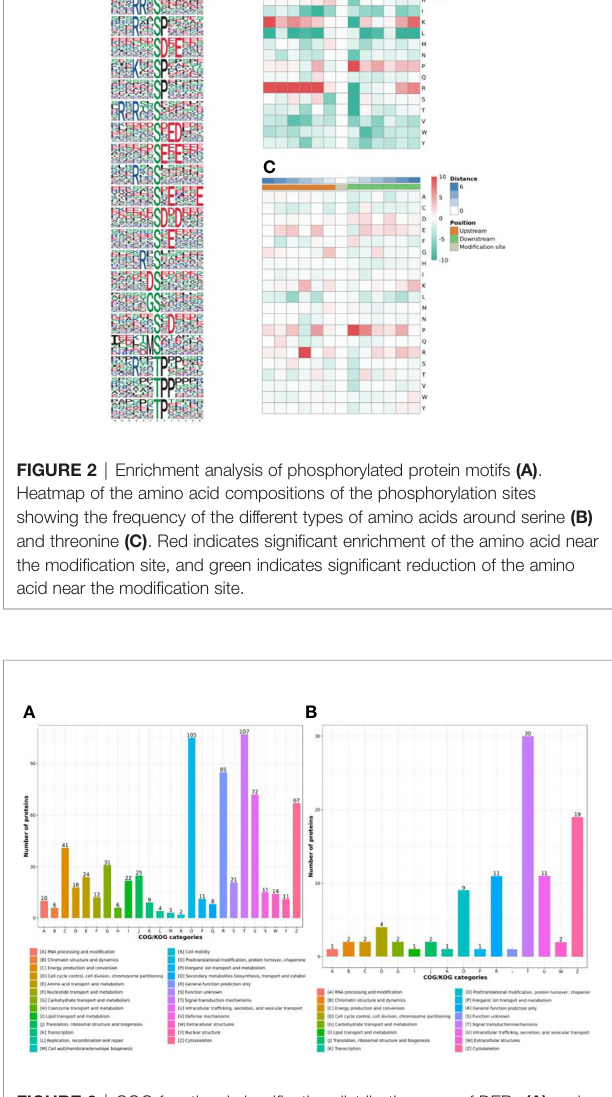
FIGURE 3 | COG functional classi fi cation distribution map of DEPs (A) and DPPs (B) .